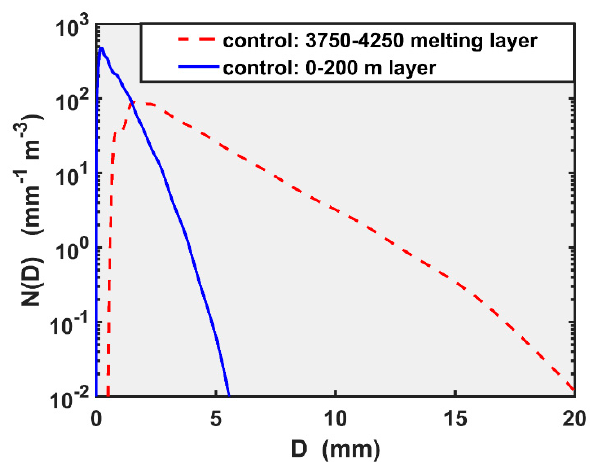
Figure 5. Size distributions from control run showing the average rain drop distribution in the 0–200 m layer and the wet snow size distribution in the layer 3750–4250 m. Note that the maximum dimension of wet snow is used for D.